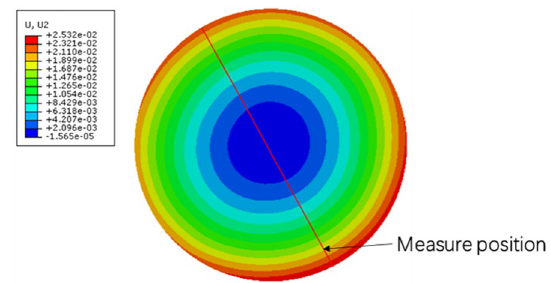
Figure 9 Deformation finite element simulation result with uneven material removal of upper and lower surfaces